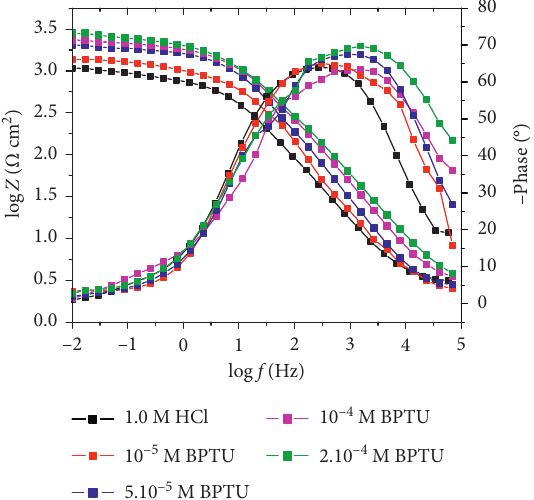
Figure 2: Bode and phase angle diagram for low carbon steel in 1.0M HCl without and with different concentrations of